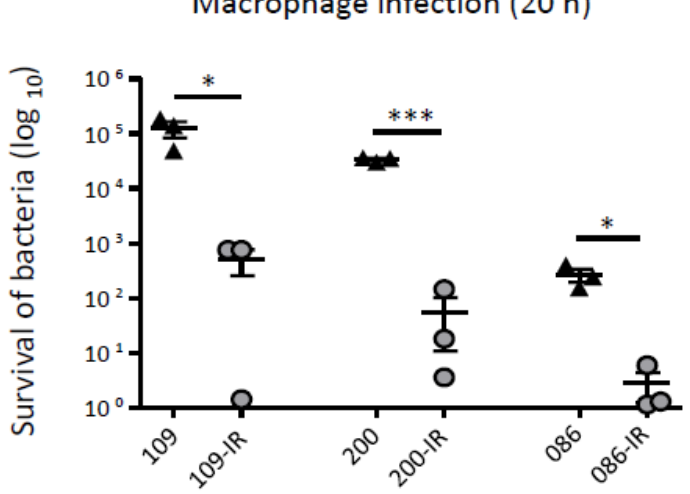
Figure 5. Result of macrophage infection assay. Survival rates of TGC-S and TGC-IR strains inside macrophages (J774A.1). The survival percentage of bacteria after 20 h was calculated by comparing to the CFUs at the 0 h time point. *, p < 0.05; ***, p < 0.0001.